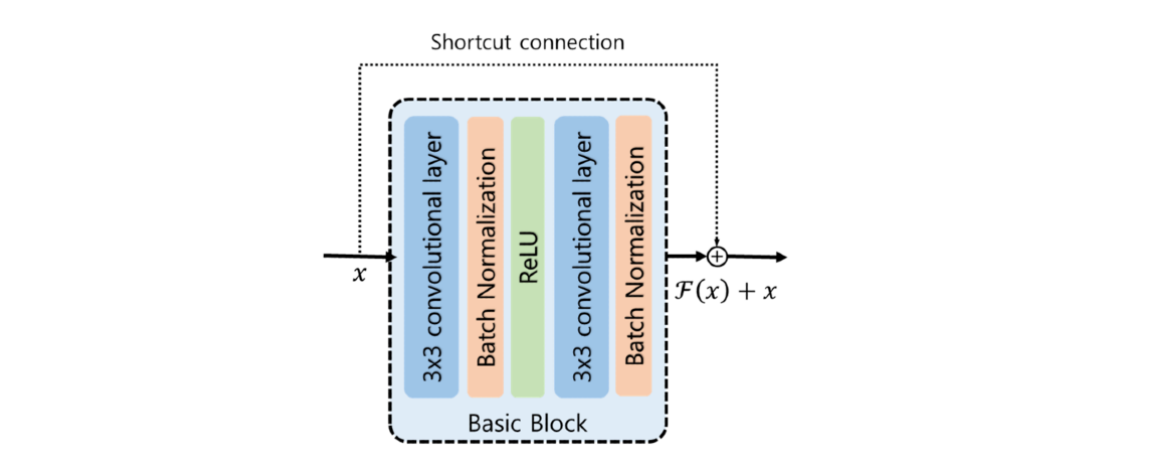
Figure 2. Structure of the basic block and the shortcut connection. The basic block consists of two 3×3 convolutional layers, two Batch Normalization layers, and a Rectified Linear Unit (ReLU) activation function. The shortcut connection adds the input vector of the basic block to the output of the basic